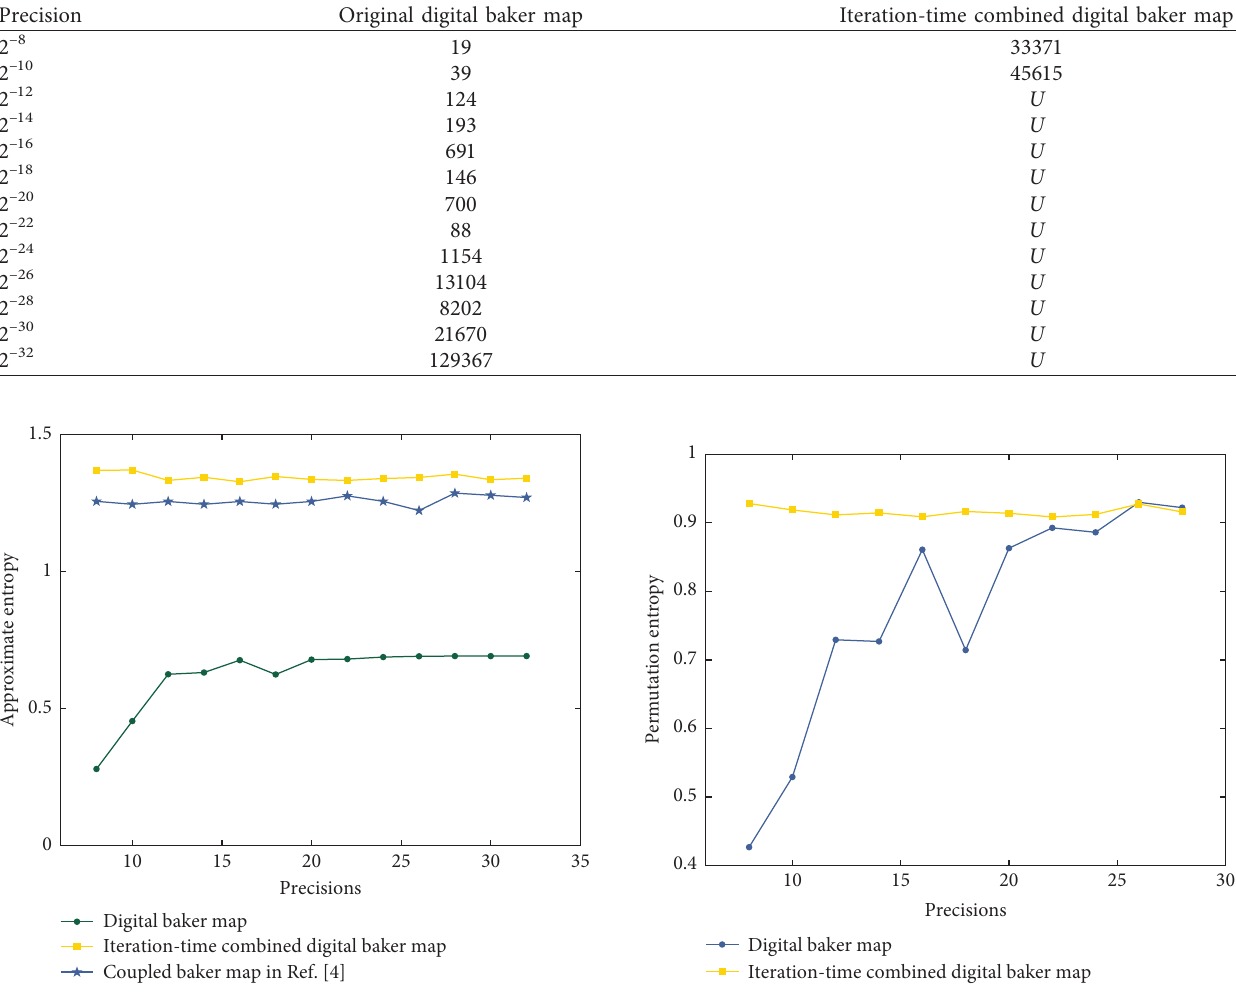
Figure 10: The PE of the digital baker map and iteration-time combined digital baker map.